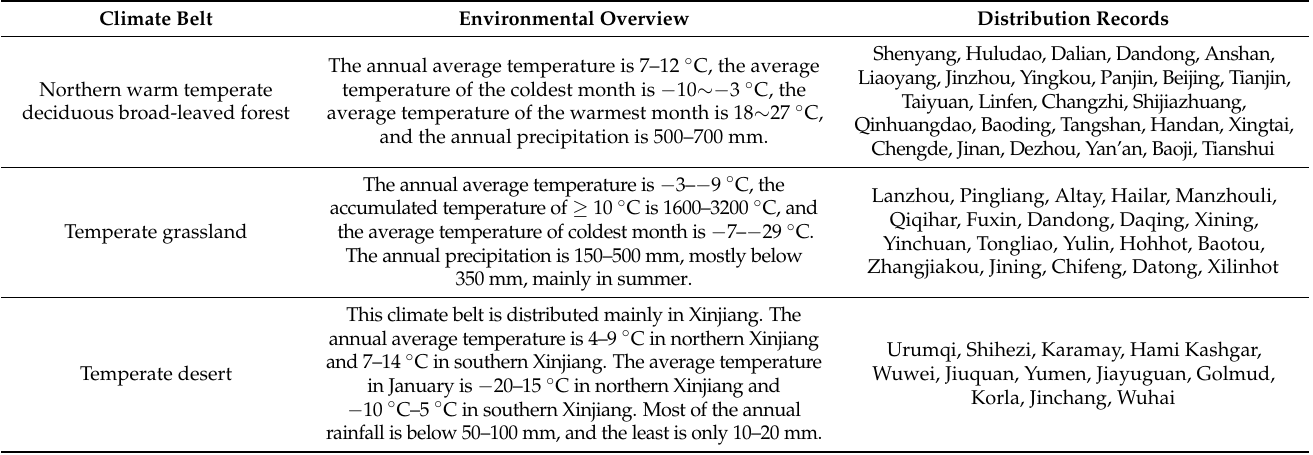
Figure 1. Occurrence records of T. klimeschi and current distribution P. alba var. pyramidalis in China. Table 1. Profile of the cultivation area of Populus alba var.